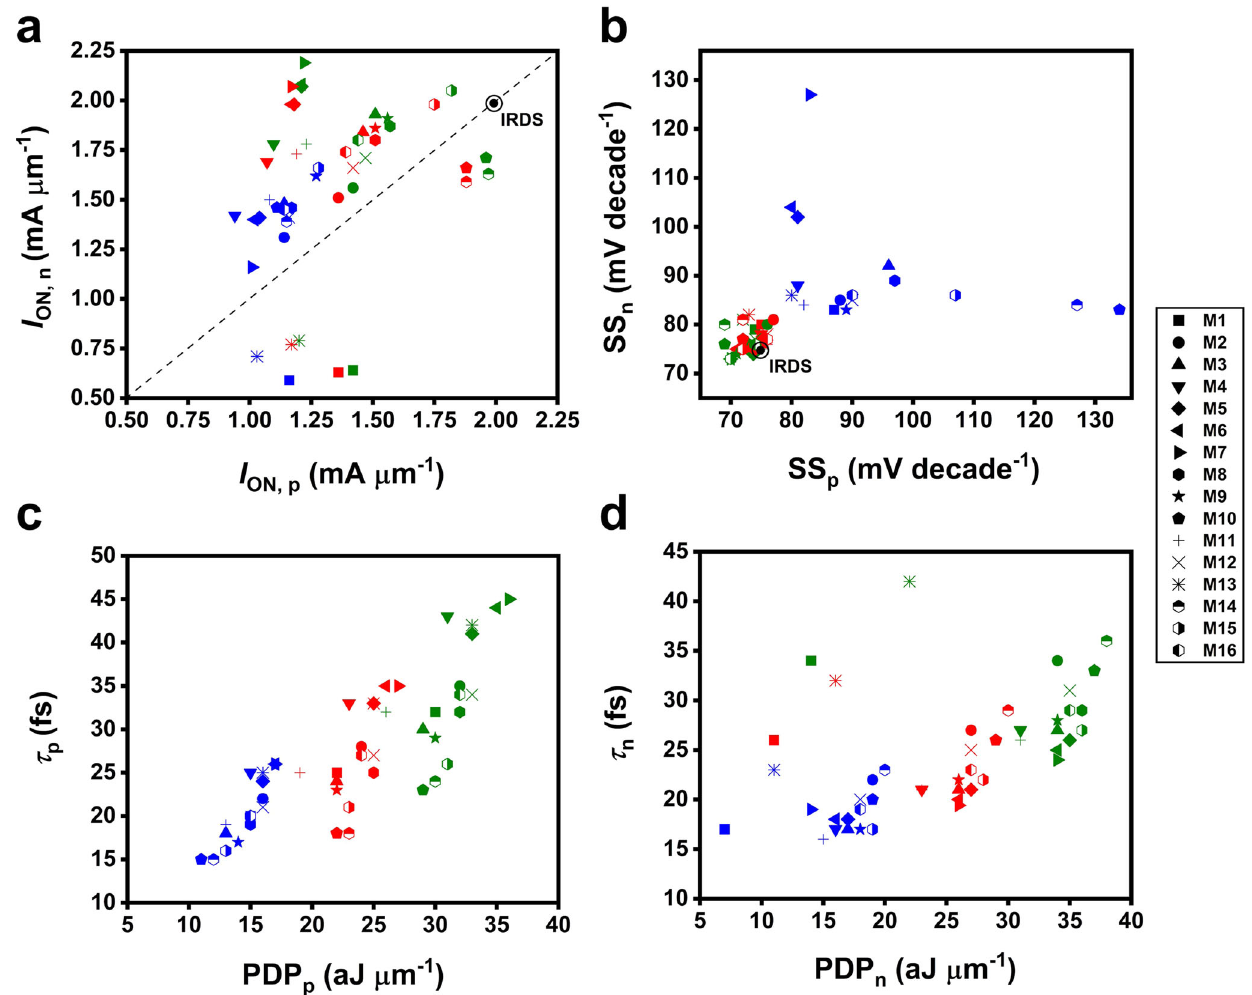
Fig. 6 Performance evaluation of 16 complementary transistors. Performance is evaluated in terms of a ON state current I ON . Devices M15, M14, and M10 have I ON close to IRDS predicted value among the 16 devices, b subthreshold swing SS. Most of the devices report a value of SS close to the IRDS predicted value, apart from the devices having a channel length of 5 nm. Performance evaluation in the τ -PDP plane of 16 c p-type transistors and d n-type transistors. Here we use the same color code as Fig.